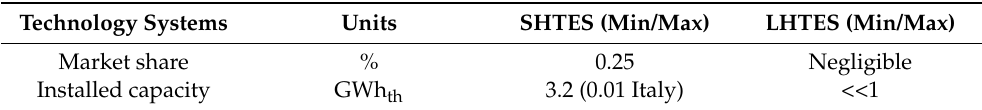
Table 6. Current typical values and range of the TES on the market. Technology